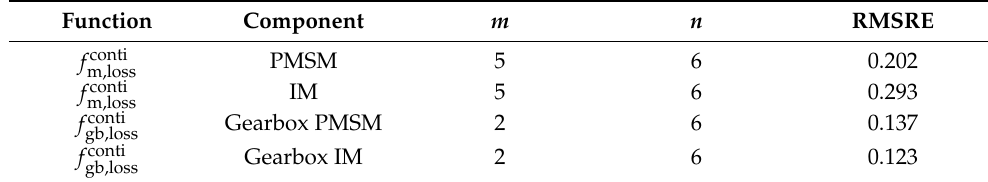
Table 3. Fitting parameters and results for the continuous high-order polynomial meta-models. The parameters m and n represent the polynomial order (coefficients m and n of Equation (5)).